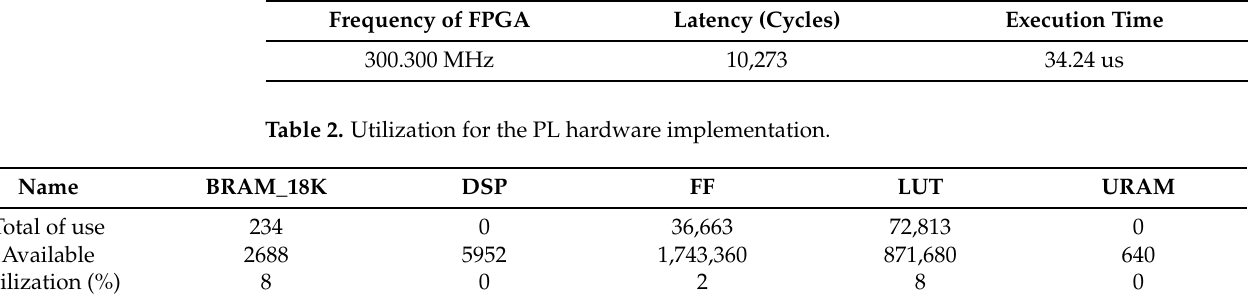
Figure 11. Device map and routing of Alveo U50 Accelerator during the hardware implementation for Memory-Tree optimization. Table 1. Performance estimates for the PL hardware implementation.